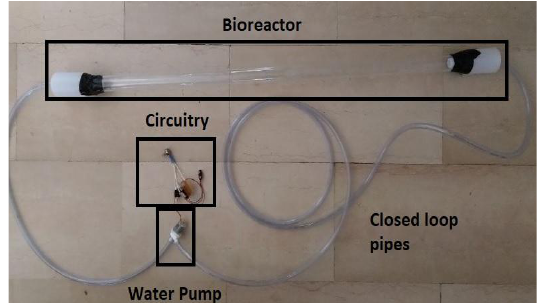
Fig. 4. Bioreactor